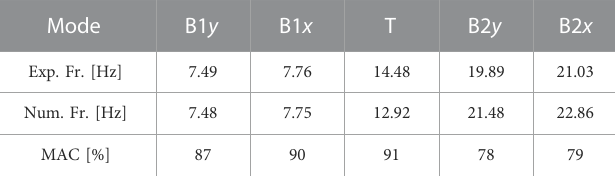
TABLE 7 ASCE benchmark structure: comparison between the experimental and the calibrated numerical modal properties of the steel braced frame. B1: fi rst bending mode; B2: second bending mode; T: torsional mode; x or y : mode